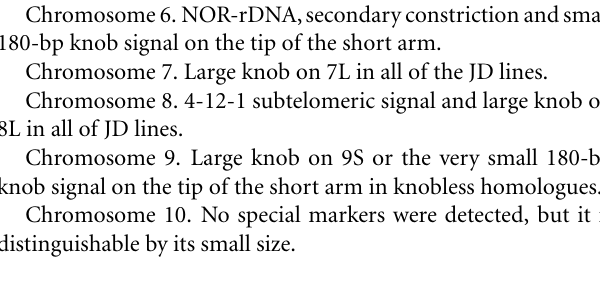
Chromosome 6. NOR-rDNA,secondary constriction and small 180-bp knob signal on the tip of the short arm. Chromosome 7. Large knob on 7L in all of the JD lines. Chromosome 8. 4-12-1 subtelomeric signal and large knob